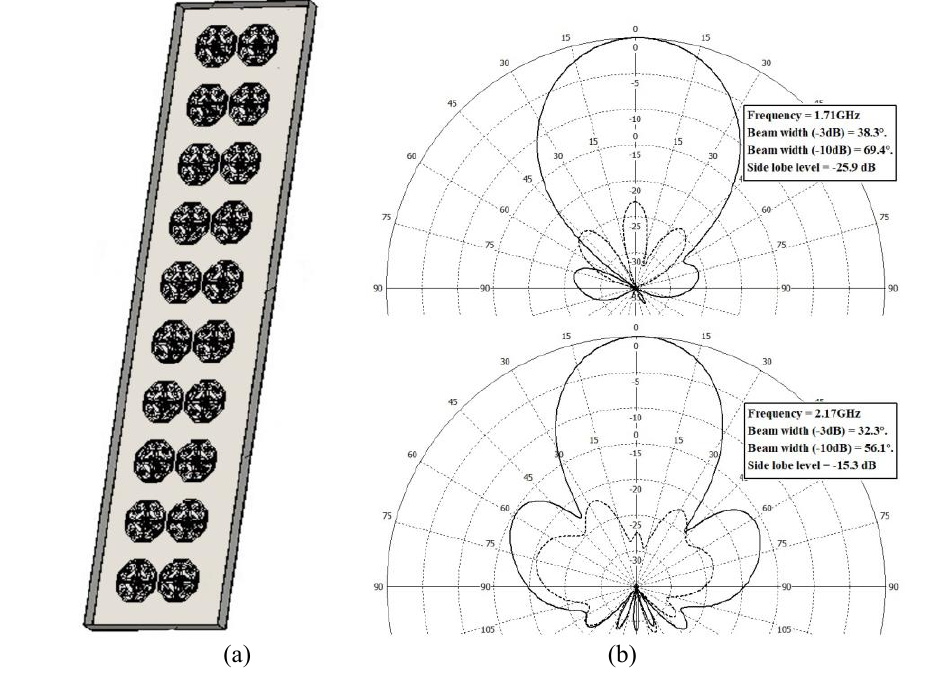
Fig. 1 . (a) top view of the antenna array, (b) normalized radiation